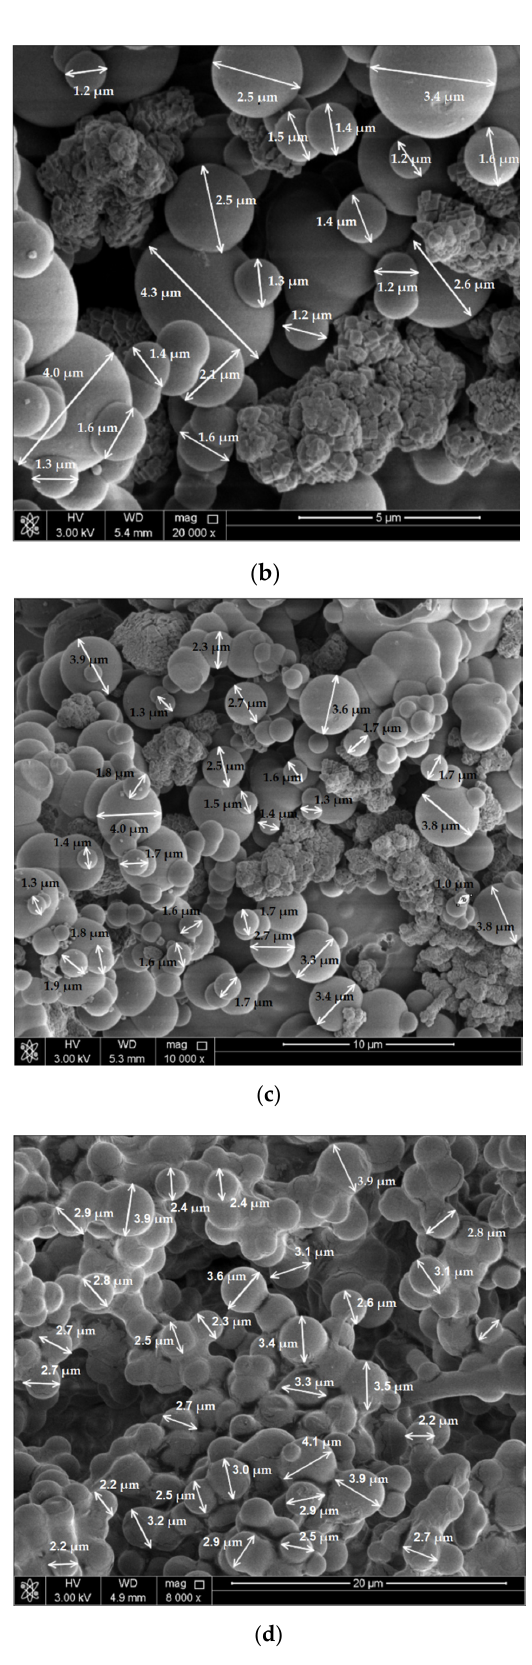
Figure 2. Microcapsule scanning electron microscope images at different scales: ( a ) 2 µm, ( b ) 5 µm, ( c ) 10 µm, and ( d ) 20 µm.